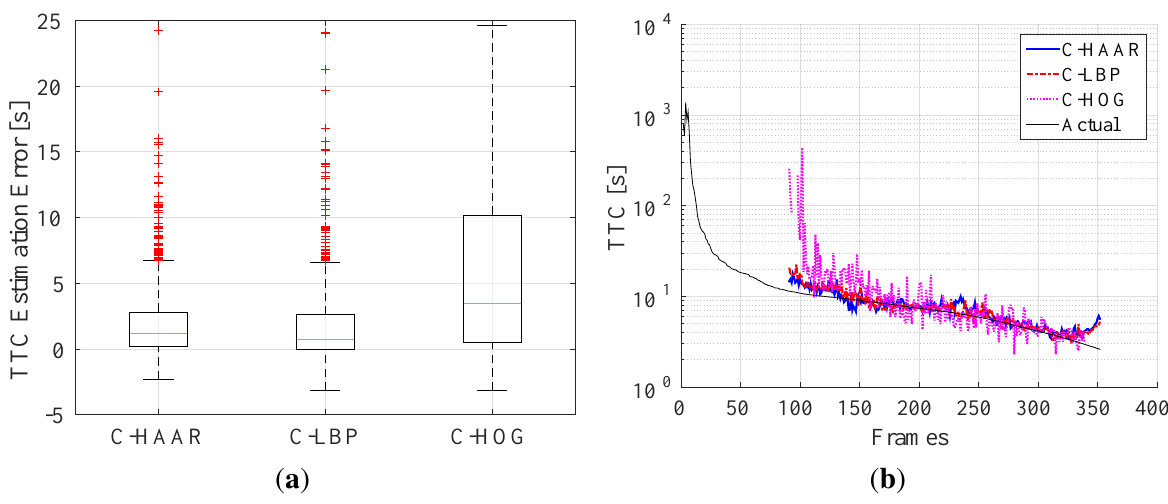
Figure 17. Indoor time to collision estimation performances of the methods for ( a ) all approach motions and ( b ) a single approach motion. In ( a ), there are outliers also outside the limits of the y-axis. However, in order to make differences between the methods observable, y-axis is limited between − 5 and 25 . In ( b ), the y-axis is in log-scale, and no estimation is available until the 90th frame. The missing points after the 90th frame are due to negative or infinite time to collision